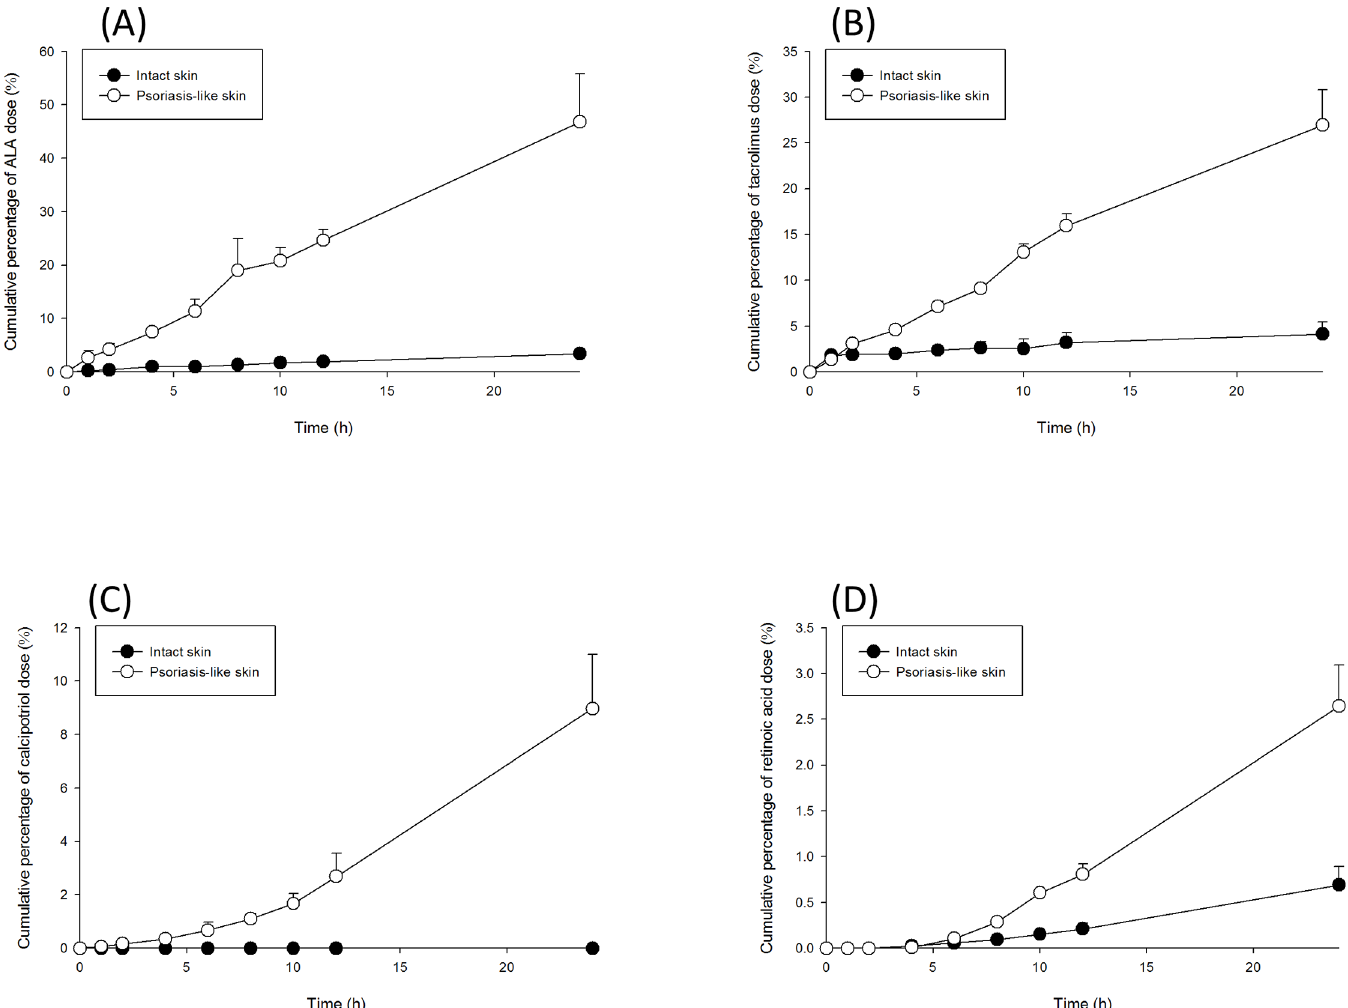
Fig 4. Cumulative percentage-time profiles of drug permeation across intact and psoriasis-like skins: (A) ALA; (B) tacrolimus; (C) calcipotriol; and (D) retinoic acid. The data of are presented as the mean of four experiments ± S.D.